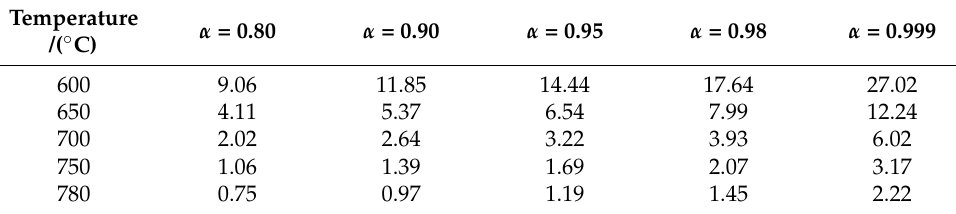
Table 3. Prediction of the time required for siderite magnetization using the kinetic equations.